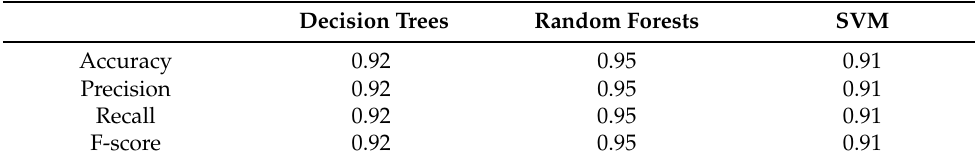
Table 8. Driving syle classification results.